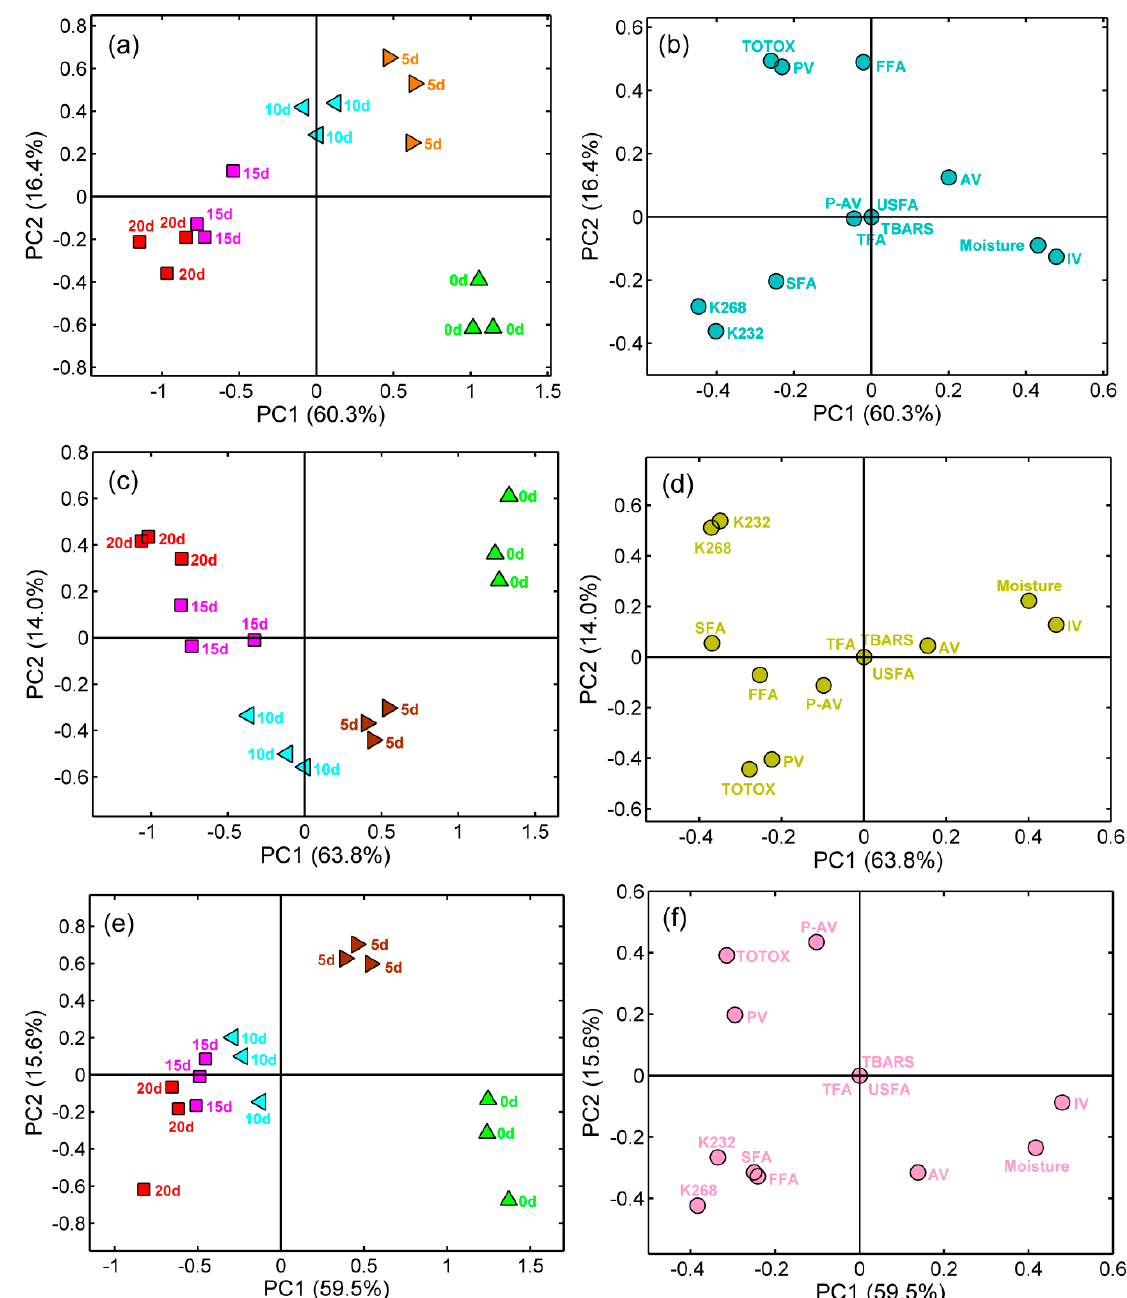
Figure 3. Component (PC) analysis of all tested samples showing a correlation of measured quality parameters during accelerated storage at 40 °C, PC1-PC2 score plot ( a ) and loading plot ( b ); 50 °C, PC1-PC2 score plot ( c ) and loading plot ( d ); 60 °C, PC1-PC2 score plot ( e ) and loading plot ( f ).